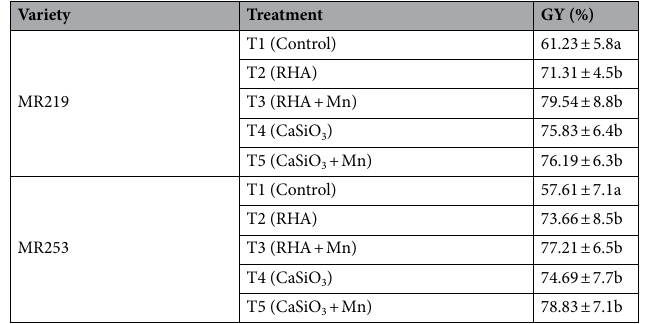
Table 6. Grain yield (GY)% of MR219 and MR253 rice varieties (harvest stage) cultivated under different treatment conditions. Treatment combinations are represented as following: T1 = control (standard fertilizer, NPK only), T2 = NPK + rice husk ash (RHA), T3 = NPK + RHA + manganese (Mn), T4 = NPK + calcium silicate